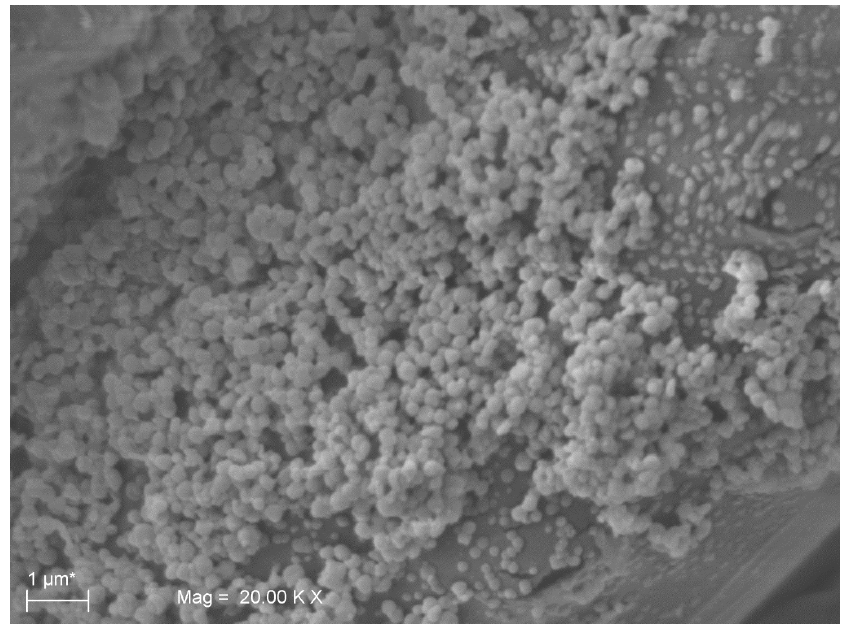
Figure 5. Representative SEM image a well-structured biofilm developed by S. aureus on suture thread. The image shows the S. aureus capability of forming an abundant biofilm on sutures without medical device (MD) treatment.